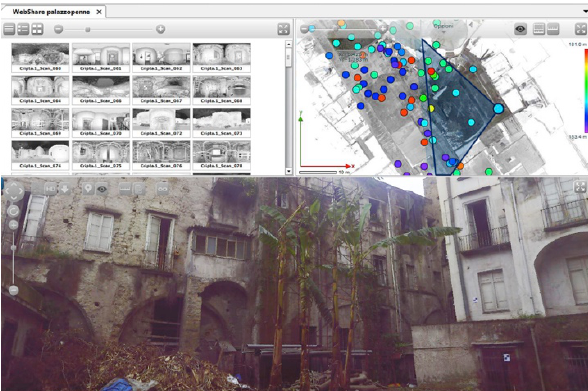
Figure 2. Palazzo Penne, internal courtyard. WebShare screenshot